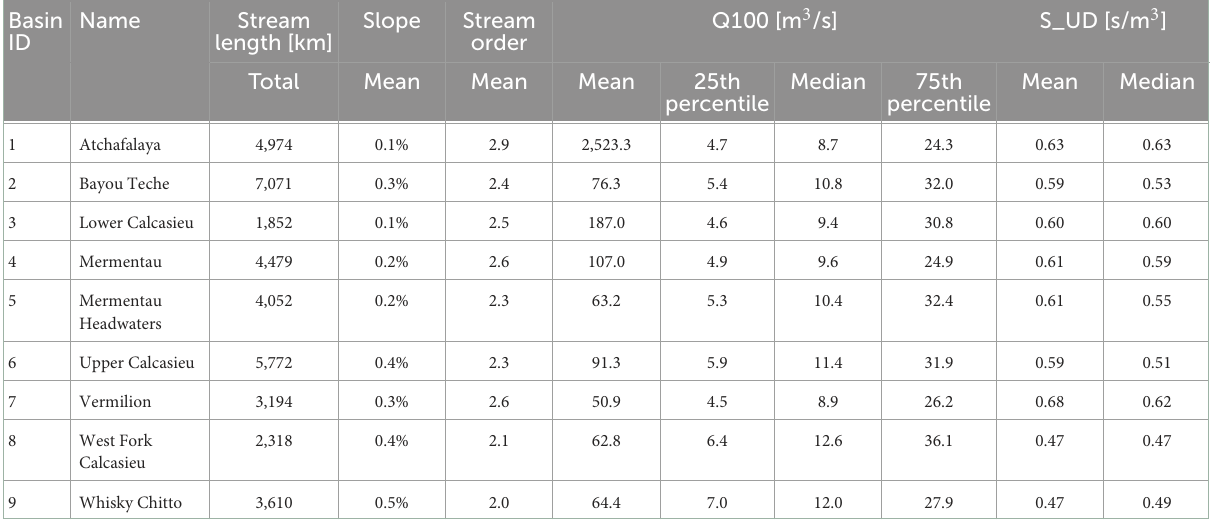
TABLE 1 Southwestern LA basin characteristics and relative flood sensitivities based on the results shown in Figure 6. Basin